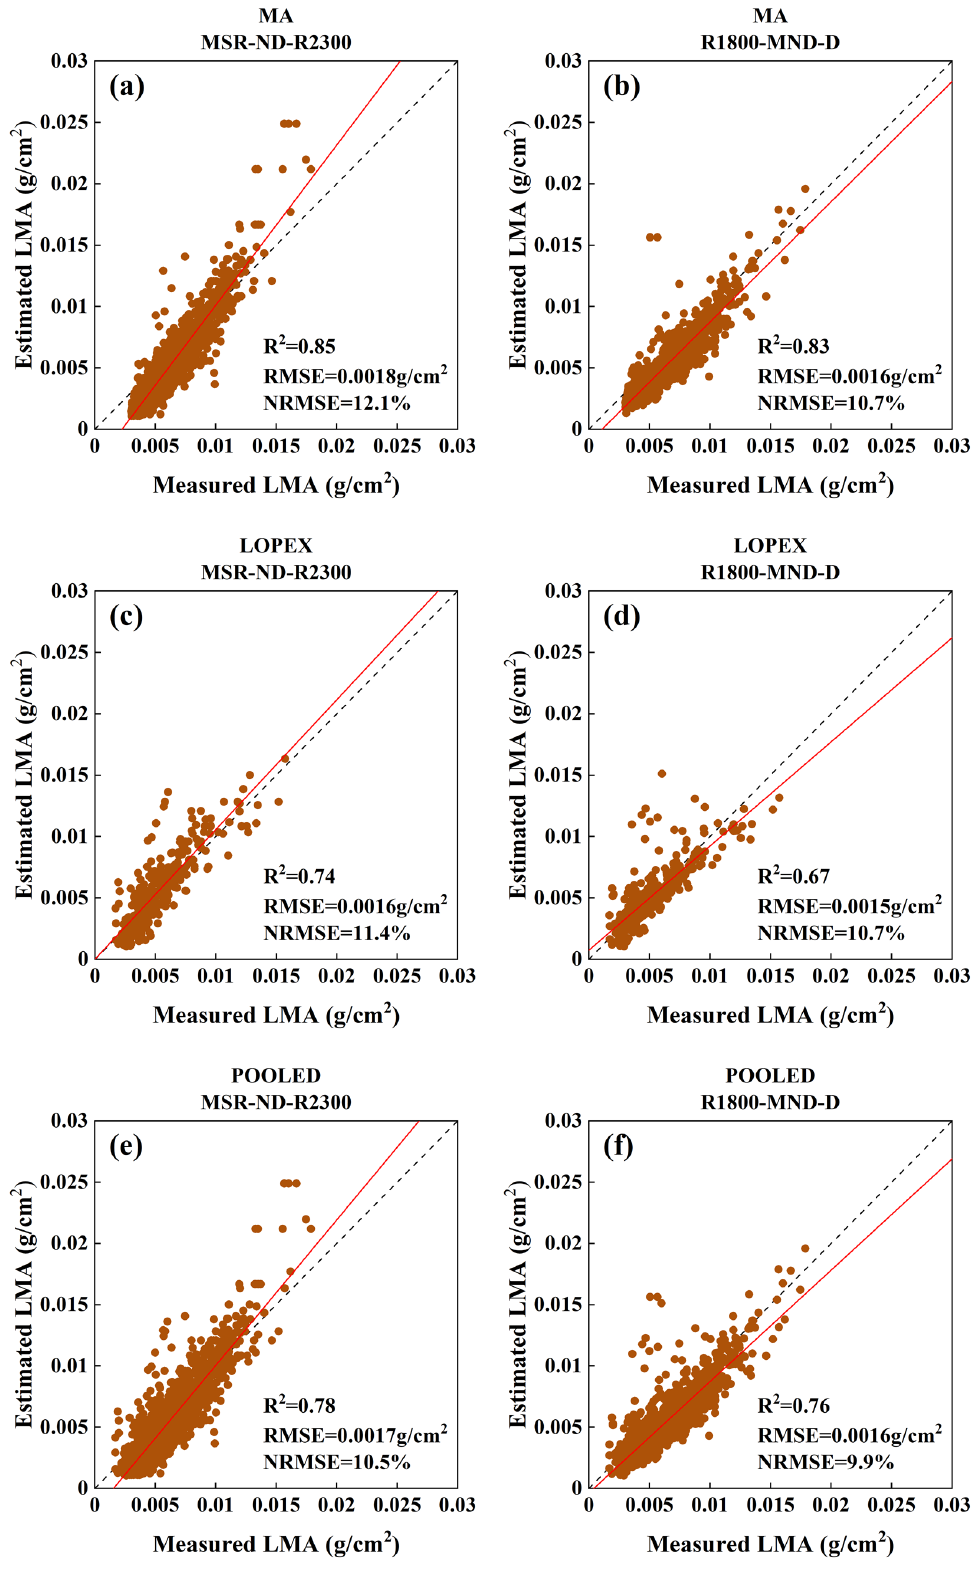
Figure 6. Estimated versus measured LMA based on matrix MSR-ND-R2300 ( a , c , e ), and R1800-MND-D ( b , d , f ) using experimental datasets LOPEX, MA, and POOLED.